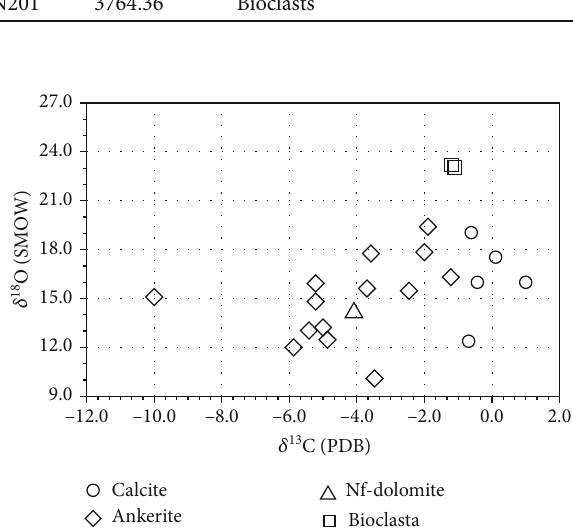
Figure 10: Distribution characteristics of carbon and oxygen isotopes for carbonate cements.